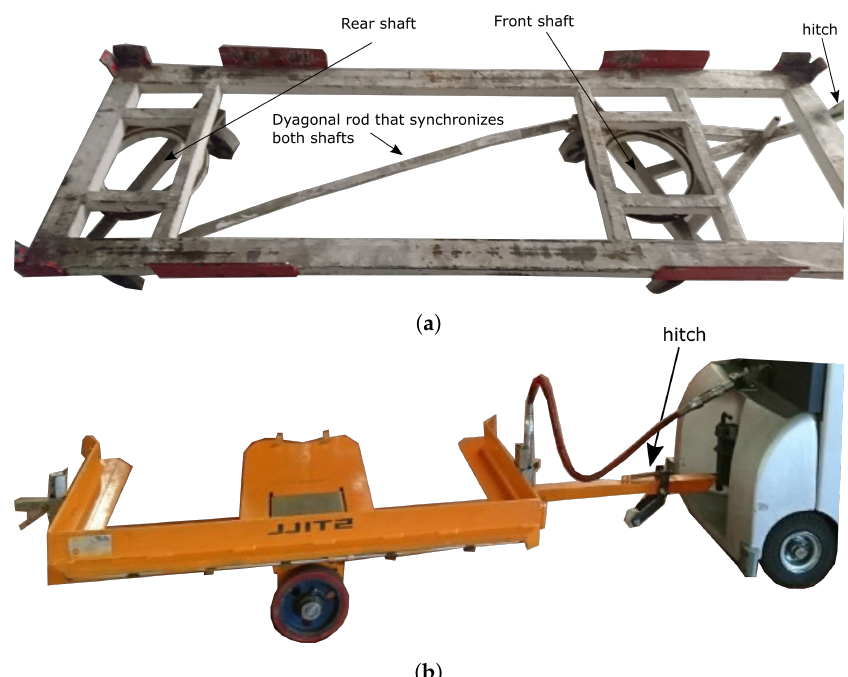
Figure 4. Trailers used in this research: ( a ) synchronized shafts trailer; ( b ) single-shaft pallet